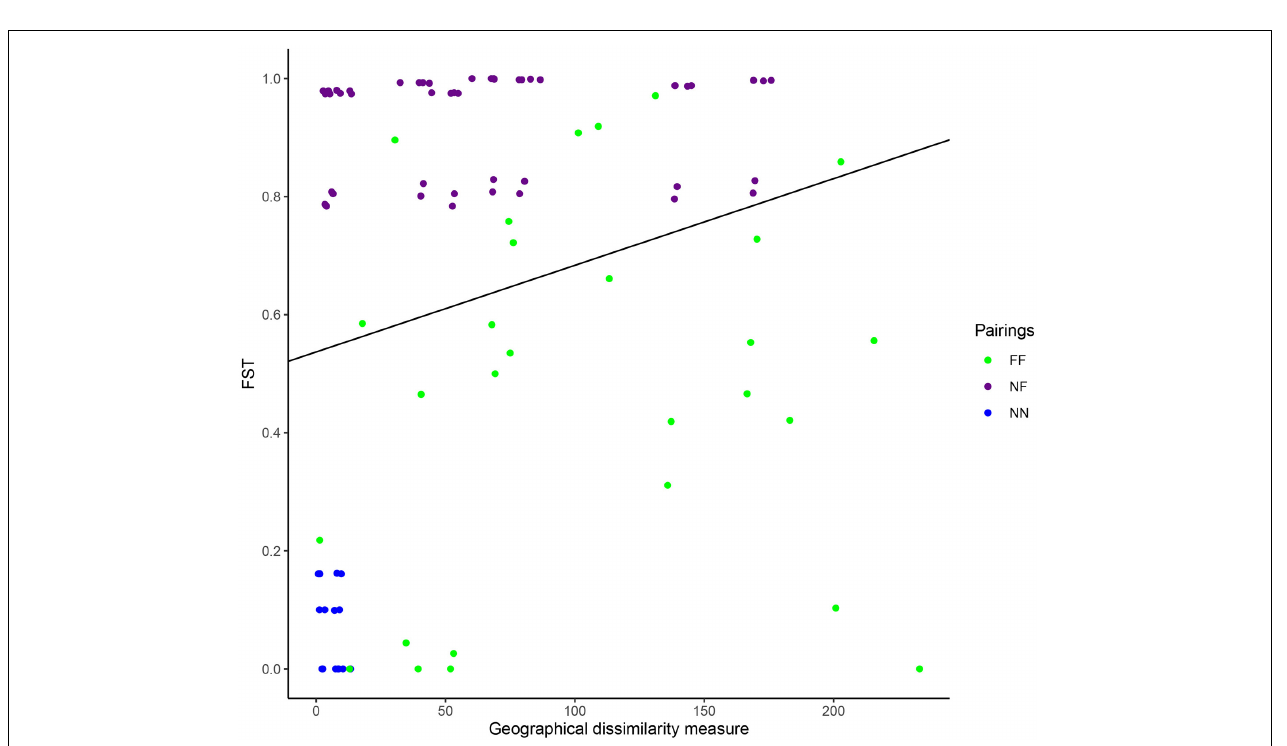
FIGURE 4 | F ST values obtained and geographical dissimilarity measure between the 14 populations of Eretmochelys imbricata , with Mantel test ( r = 0.2302, p = 0.007). FF, Feeding area X Feeding area; NF, Feeding area X Nesting area; NN, Nesting area X Nesting area.